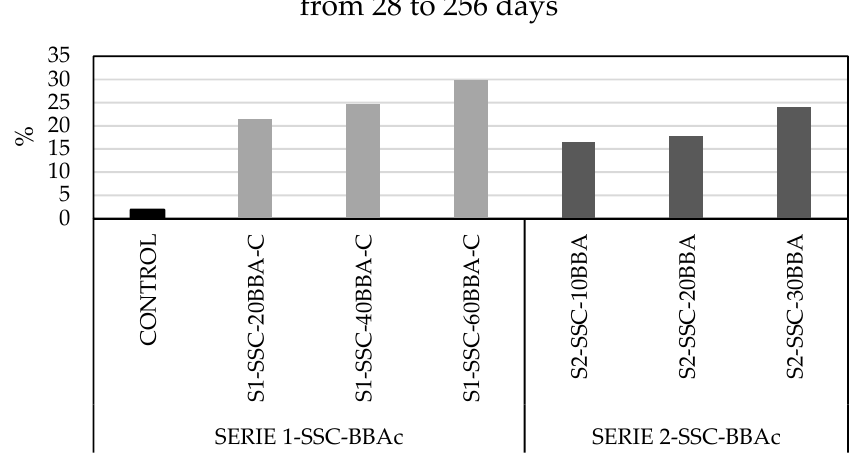
Figure 5. Comparative of increase in compressive strength from 28 to 256 days.